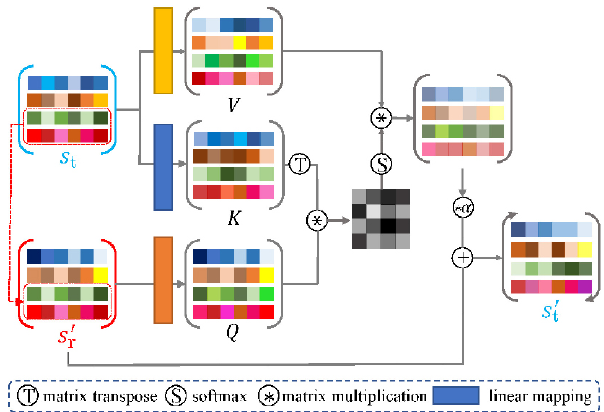
Fig. 4 Multi-region style attention module. s t : target style vectors of all regions. s 0 r : concatenation of styles from target regions in the reference and styles from the remaining regions in the target. Linear projection metrics W v , W q , and W k are used to produce V , Q , and K , respectively. Then, V and Q are used to yield an attention matrix M . Finally, the multi-region style correction is calculated by applying MV to s 0 r